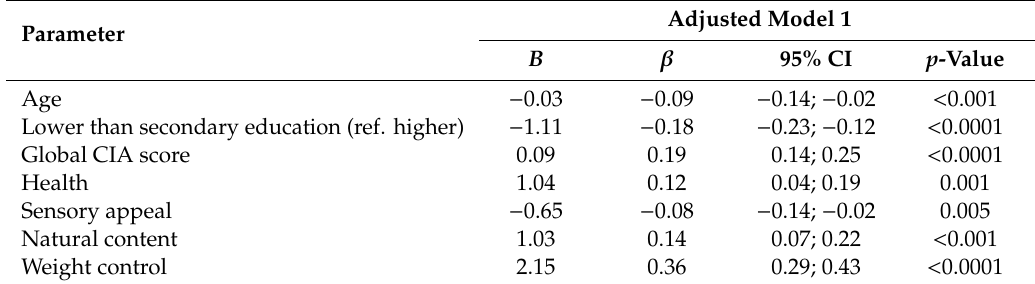
Table 5. Multiple linear regression analysis of orthorexic behaviors (ORTO-15) in the study sample. Parameter